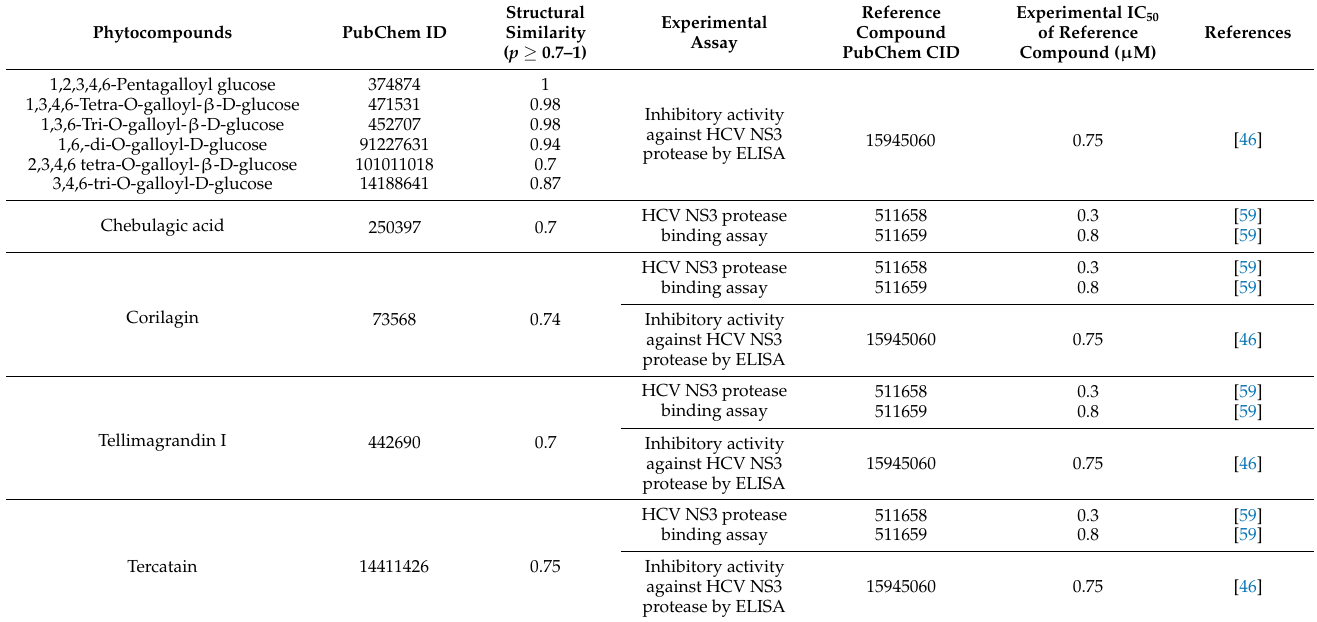
Table 1. List of phytocompounds from T. chebula predicted to inhibit HCV NS3/4A.